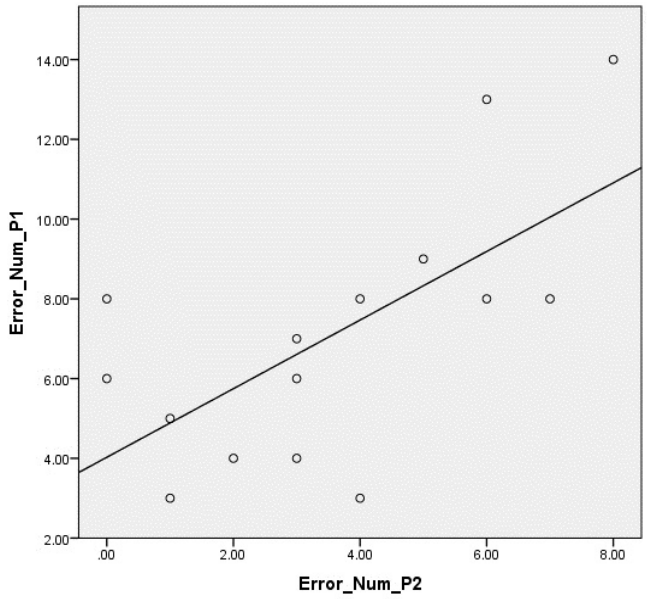
Figure 4. Correlation graph between the number of errors during the first and second sessions.